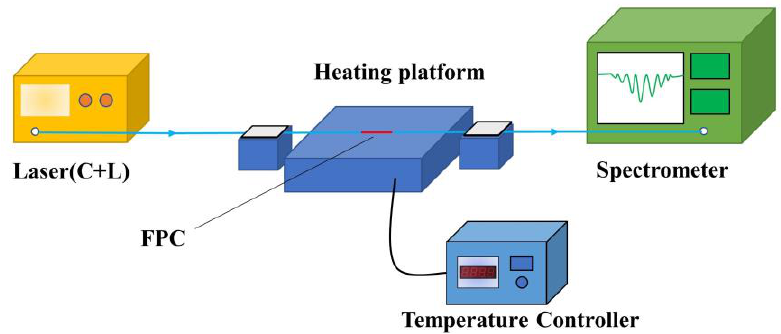
Figure 7. The schematic configuration of the temperature response test system.